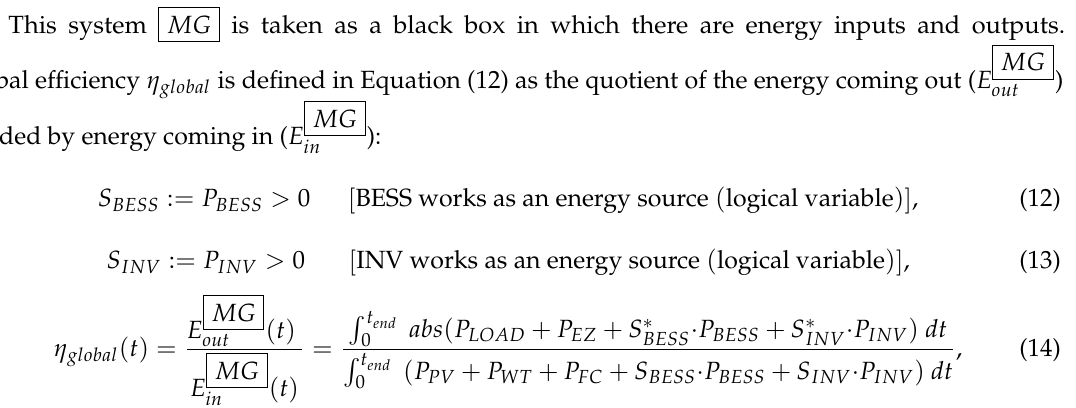
Figure 5. Possible power flows in the MG. The green rectangle defines the system 𝑀𝐺 .